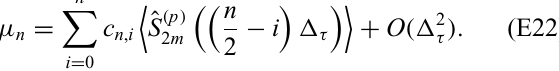
FIG. 20. Quantum circuit to evaluate Re (cid:9) (cid:6) |ˆ Im (cid:9) (cid:6) S 2 ((cid:3) τ ) | (cid:6) (cid:3) . θ in the circuit denotes the phase gate such that ˆ θ | 0 (cid:3) = | 0 (cid:3) and ˆ θ | 1 (cid:3) = e i θ | 1 (cid:3) . Since P 0 − P 1 = |ˆ Re[ e i θ (cid:9) (cid:6) S 2 ((cid:3) τ ) | (cid:6) (cid:3) ], one can evaluate Re (cid:9) (cid:6) |ˆ 0 and Im (cid:9) (cid:6) S 2 ((cid:3) τ ) | (cid:6) (cid:3) if θ = − π/ 2 from the difference of the probabilities P 0 and P 1 . Here, P b is the probability for finding